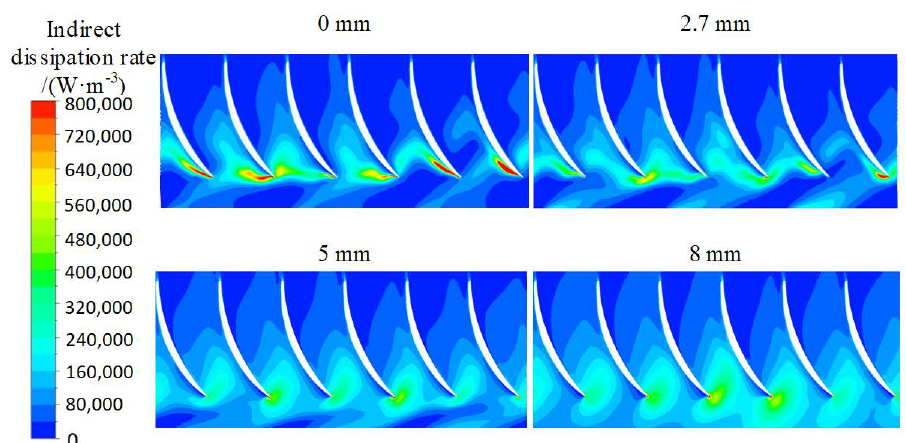
Figure 16. Indirect dissipation rate at Span = 0.015 in guide vane passage with varying root clearances ( R t = 0 mm, 2.7 mm, 5 mm 8 mm; Q = 1.0 Q des